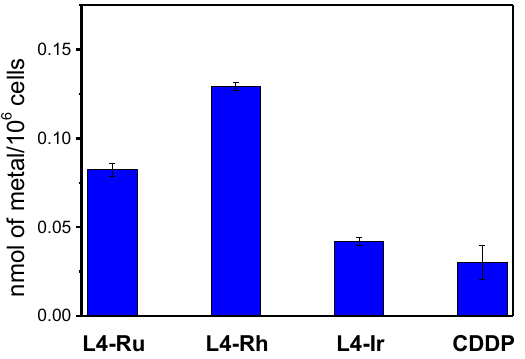
Figure 13. Metal accumulation in A549 cells after 24 h of treatment with 5 µM of the compounds under study. Cisplatin is included for comparison.